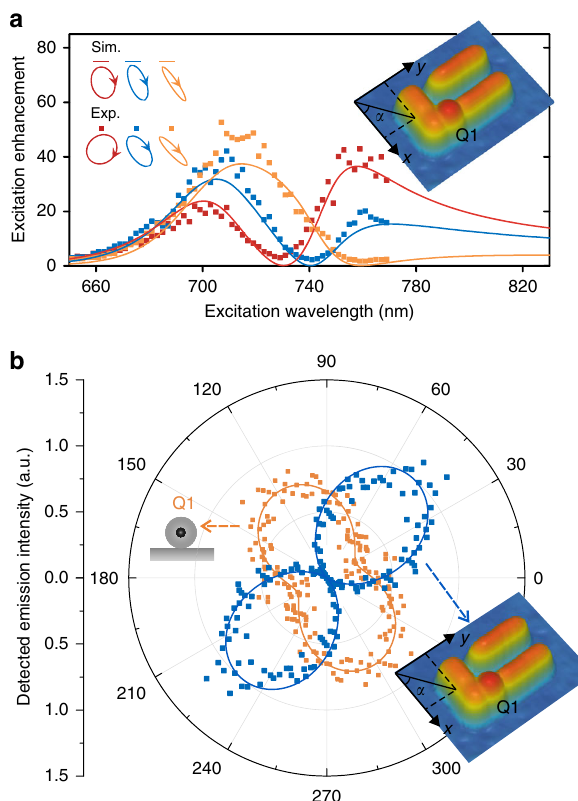
Fig. 2 Experimental control of the excitation spectra and emission polarization with only Q1 in the nanosystem. a Excitation enhancement spectra when we excite with three different elliptical polarizations (indicated by the ellipses in the upper-left corner of the panel) optimized for excitation suppression at 730 nm (red), 740 nm (blue) and 760 nm (orange). b Polar plots of the emission polarization measurements (detected intensity vs. the angle of the linear polarizer) for Q1 before (orange data points) and after (blue data points) it couples to the gold nanostructure. The blue continuous curve is the simulated result while the orange continuous curve is a sinusoidal fi